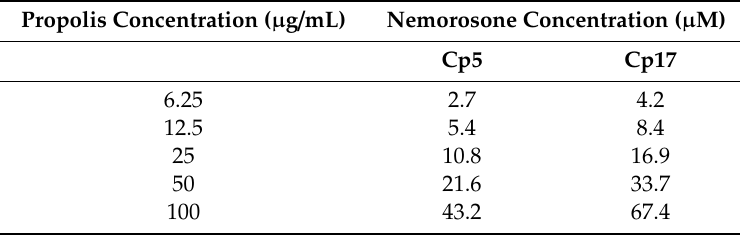
Table 1. Sample nemorosone (Nem)